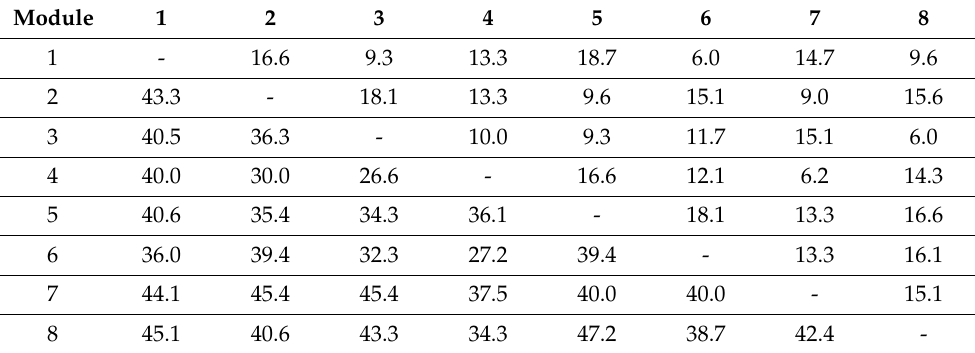
Table 1. Degree of sequence identity (upper half of the table) and similarity (lower half) between the eight HisA modules of D. fermentas DSM 18053. Numbers: 1, 2, 3, 4, 5, 6, 7, 8 correspond to aa